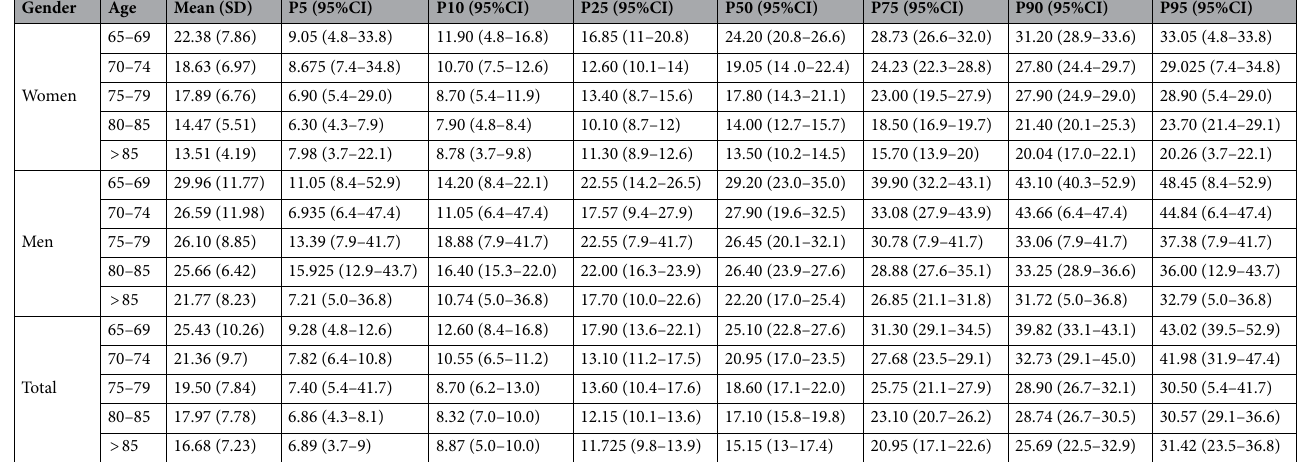
Table 2. Handgrip strength stratified by age groups, for both women and men. P: percentile, CI: confidence interval, SD: standard deviation.